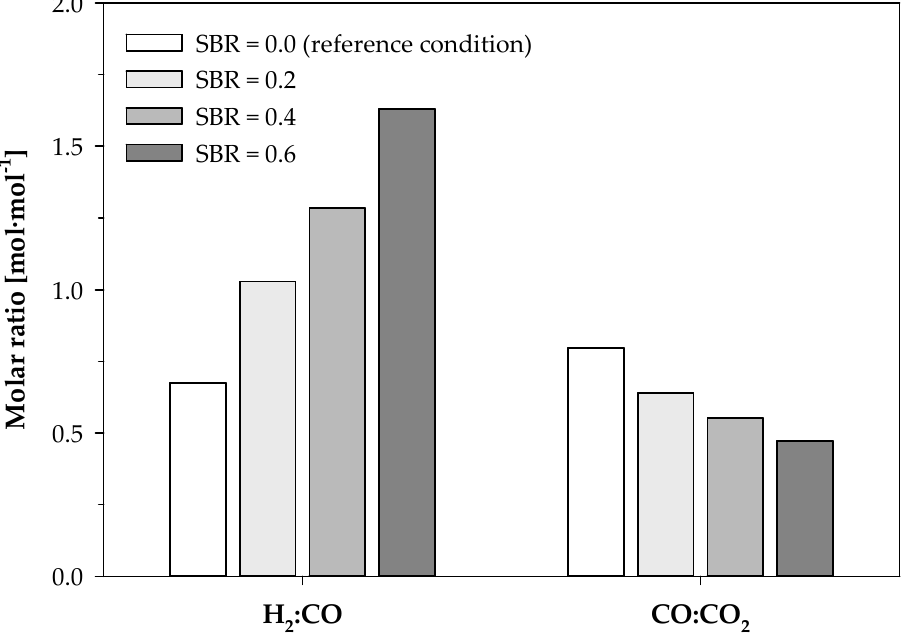
Figure 5. Effect of steam addition on the H 2 :CO and CO:CO 2 molar ratios during air gasification of RFB from eucalyptus ( φ = 20 %vol. O ₂ , dry GA —Tables 3 and 4).